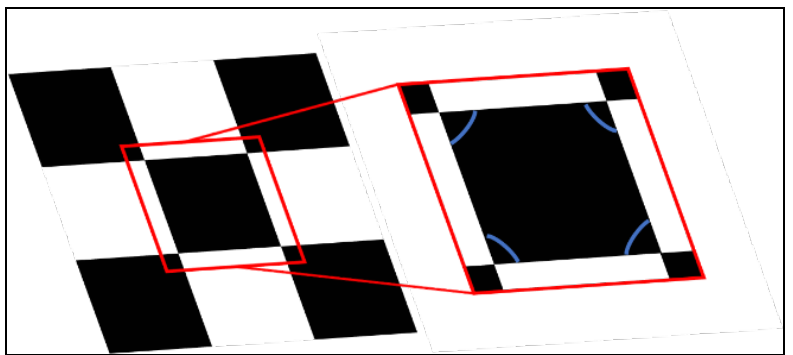
Figure 7. The vertices of squares on the camera calibration board when an angle error occurs on at least two axes.